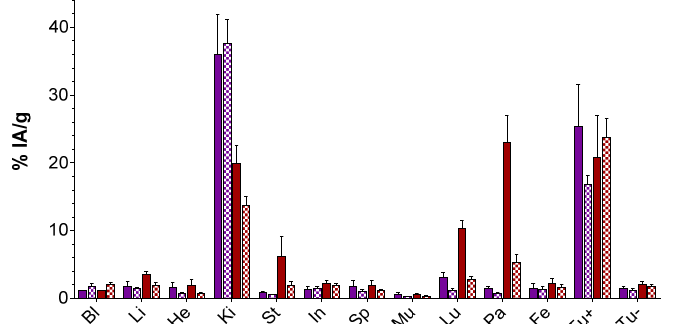
Figure 4. Comparative biodistribution of (cid:4) [ 67 Ga]Ga-DOTA-LM3 and (cid:4) [ 67 Ga]Ga-DATA 5m -LM4 in SCID mice bearing twin HEK293-SST 2 R and wtHEK293 xenografts, at 1 h (solid bars) and 4 h (chequered bars) pi. Results are expressed as %IA/g and represent the average values ± sd, n = 4; Bl: blood, Li: liver, He: heart, Ki: kidneys, St: stomach, In: intestines, Sp: spleen, Mu: muscle, Lu: